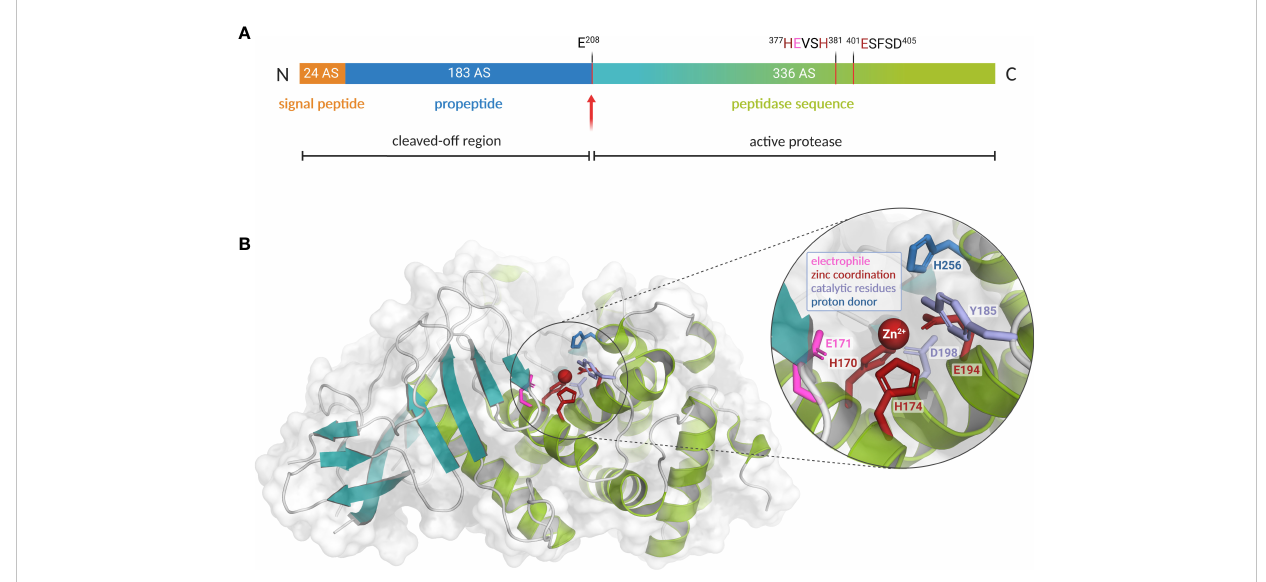
FIGURE 2 Preproenzyme composition, structure and catalytic center of L. pneumophila M4 zinc metalloprotease ProA. (A) Schematic overview of the ProA preproenzyme containing a signal- and a propeptide (60 kDa, 543 amino acids). Secretion and autoprocessing at residue Glu 208 results in a 38 kDa mature peptidase unit (teal and green). Important residues for cofactor coordination (red) and proteolytic activity (pink) are highlighted within the zinc-binding motifs. Especially the HExxH motif is highly conserved among the M4 family of TLPs. (B) Two domain structure of ProA (PDB code: 6YA1) with N-terminal b -sheets (teal) and C-terminal a -helices (green). A close-up of the active center displays the zinc cofactor as well as amino acid residues for coordination and catalysis (created with PyMOL 2.0 and